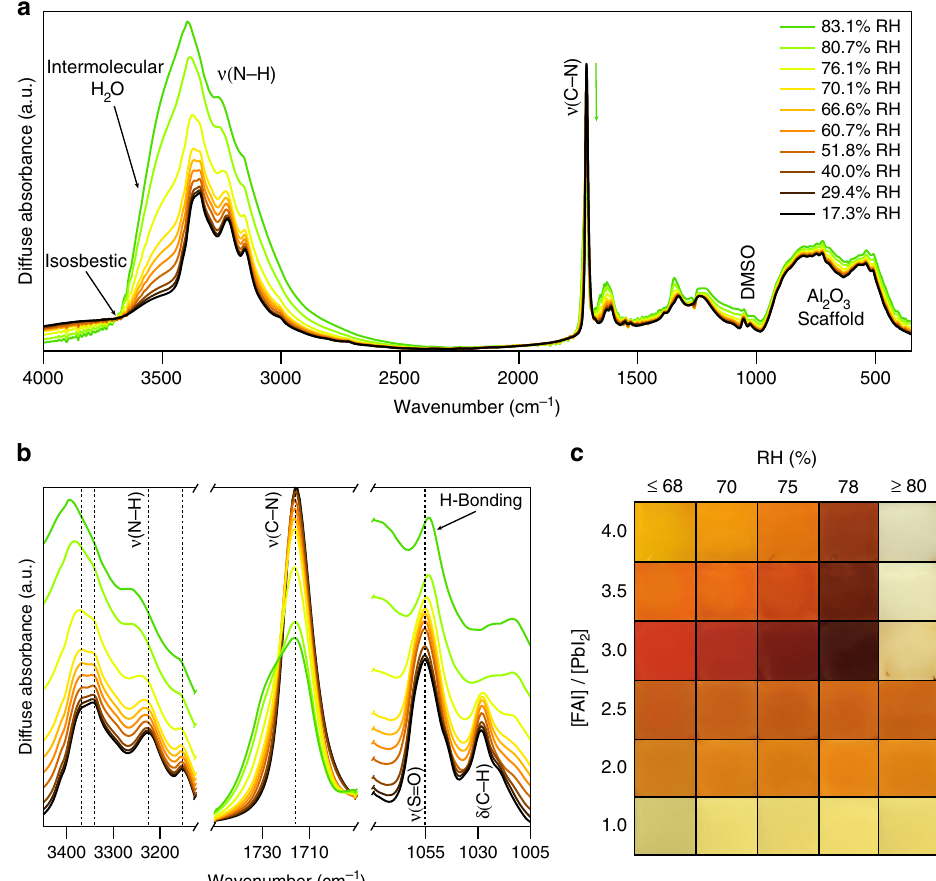
Fig. 3 Molecular interactions are the thermodynamic driving force for reversible chromism. a Representative diffuse-re fl ectance infrared Fourier transform spectroscopy (DRIFTS) spectra collected at various relative humidity (RH) and extracted from Supplementary Fig. 13. b Spectra focused on the H-bonding regions of the composite fi lm: N – H stretch region of FA + , C – N asymmetric stretch region of FA + , and the S = O stretch and C – H rocking regions of dimethyl sulfoxide (DMSO). Dashed vertical lines indicate peak location at 17.3% RH. c Optical photographs showing the effect of changing the number of molecular interactions on the hygrochromic properties by varying the FAI:PbI 2 ratio and RH. [PbI 2 ] = 0.75 M in DMSO was held constant in all precursors, which were spun onto a 1.58 ± 0.02 µ m Al 2 O 3 scaffold and annealed at 60 °C for 10 min. DRIFTS spectra and optical photographs were collected on fi lms with a FAI:PbI 2 ratio of